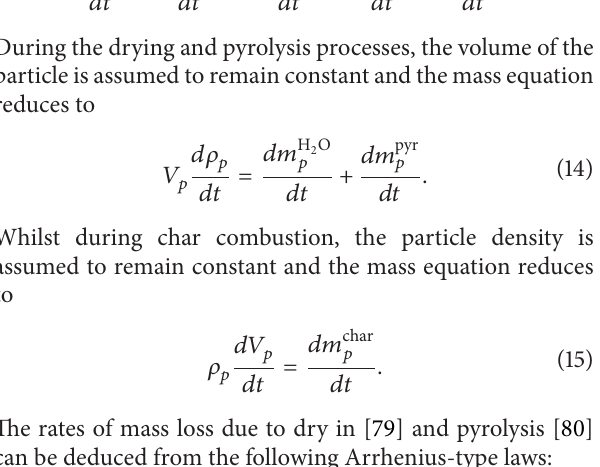
Figure 1: Computational domain of a deciduous